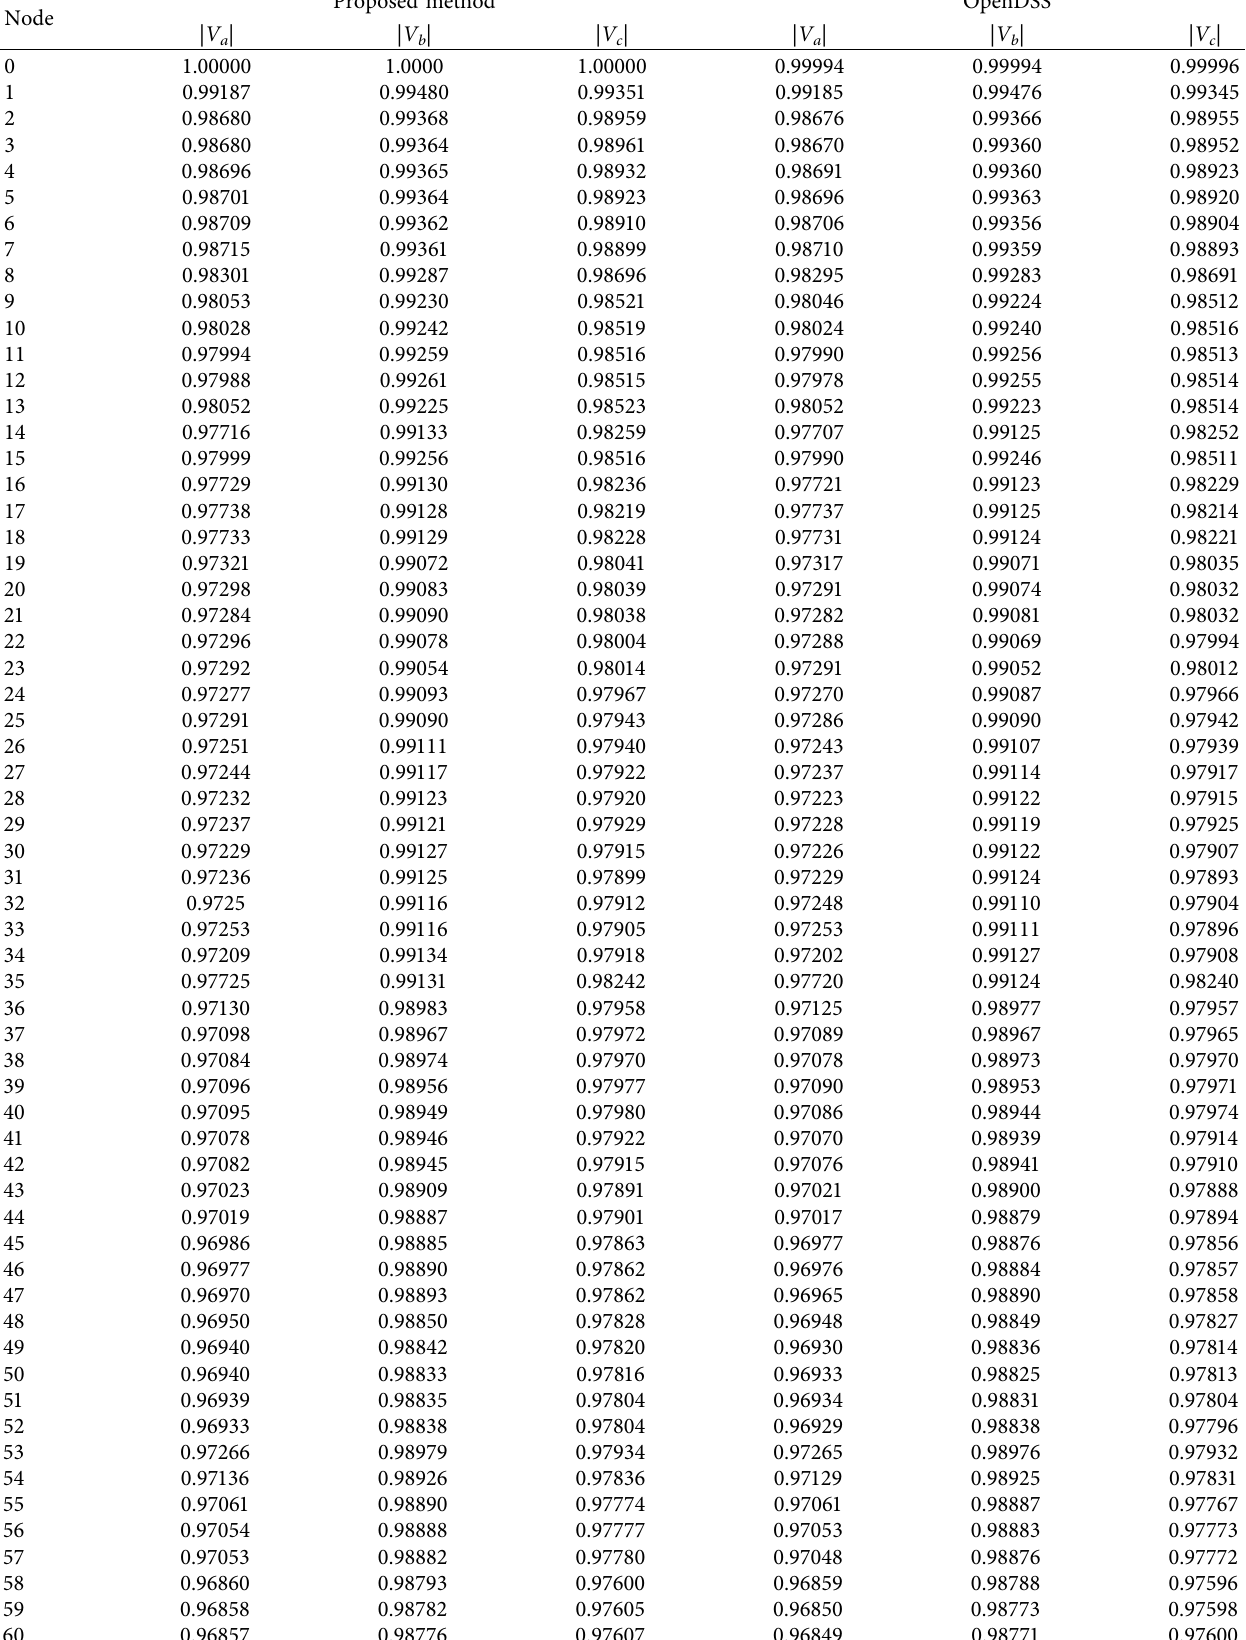
Table 12: Voltage profile of 123-bus